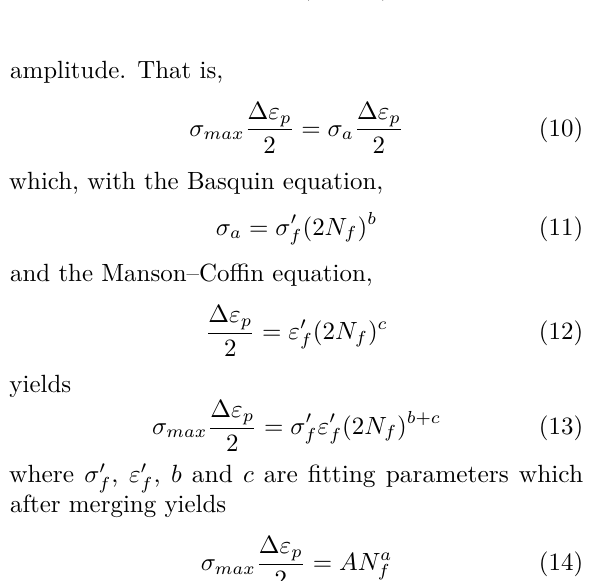
Figure 2. Comparison between experimentally determined stresses and calculated from Eqn. 6, 7 and 8; for two different strain ranges at 450 °C, a) and b), and at two different strain ranges at 550 °C, c) and